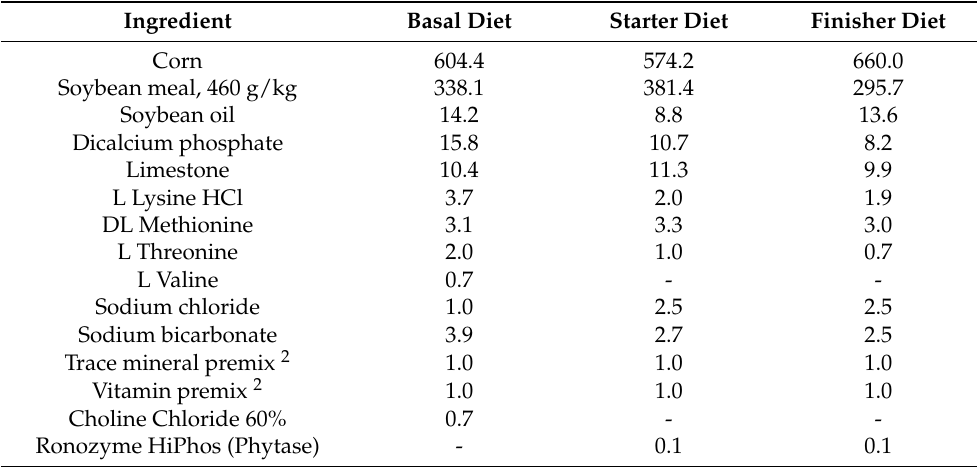
Table 2. Composition (g/kg, as fed basis) of the basal diet used in the apparent metabolizable energy assay and, of pre-assay diets fed to broiler starters (d 1 to 21) and finishers (d 22 to 35) 1 . Ingredient Basal Diet Starter Diet Finisher Diet Corn 604.4 574.2 660.0 Soybean meal, 460 g/kg 338.1 Soybean